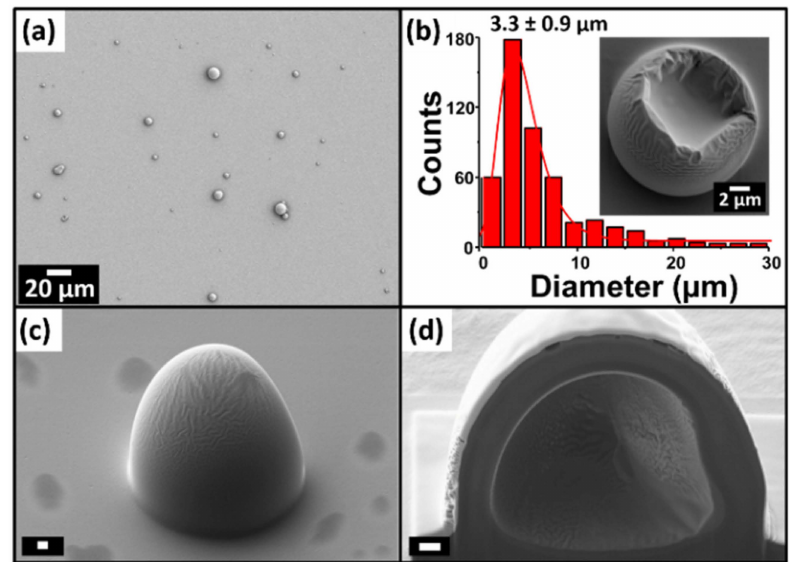
Figure 3. Field emission scanning electron microscopy (FE-SEM) images of PGMA- b -Ru(bpy) 3 - b -PHPMA triblock copolymer vesicles ( a ). Histogram of the vesicle diameters based on the FE-SEM measurements (inset: magnified SEM image of a single vesicle) ( b ). FE-SEM images before ( c ) and after ( d ) milling (scale bar = 1 µ